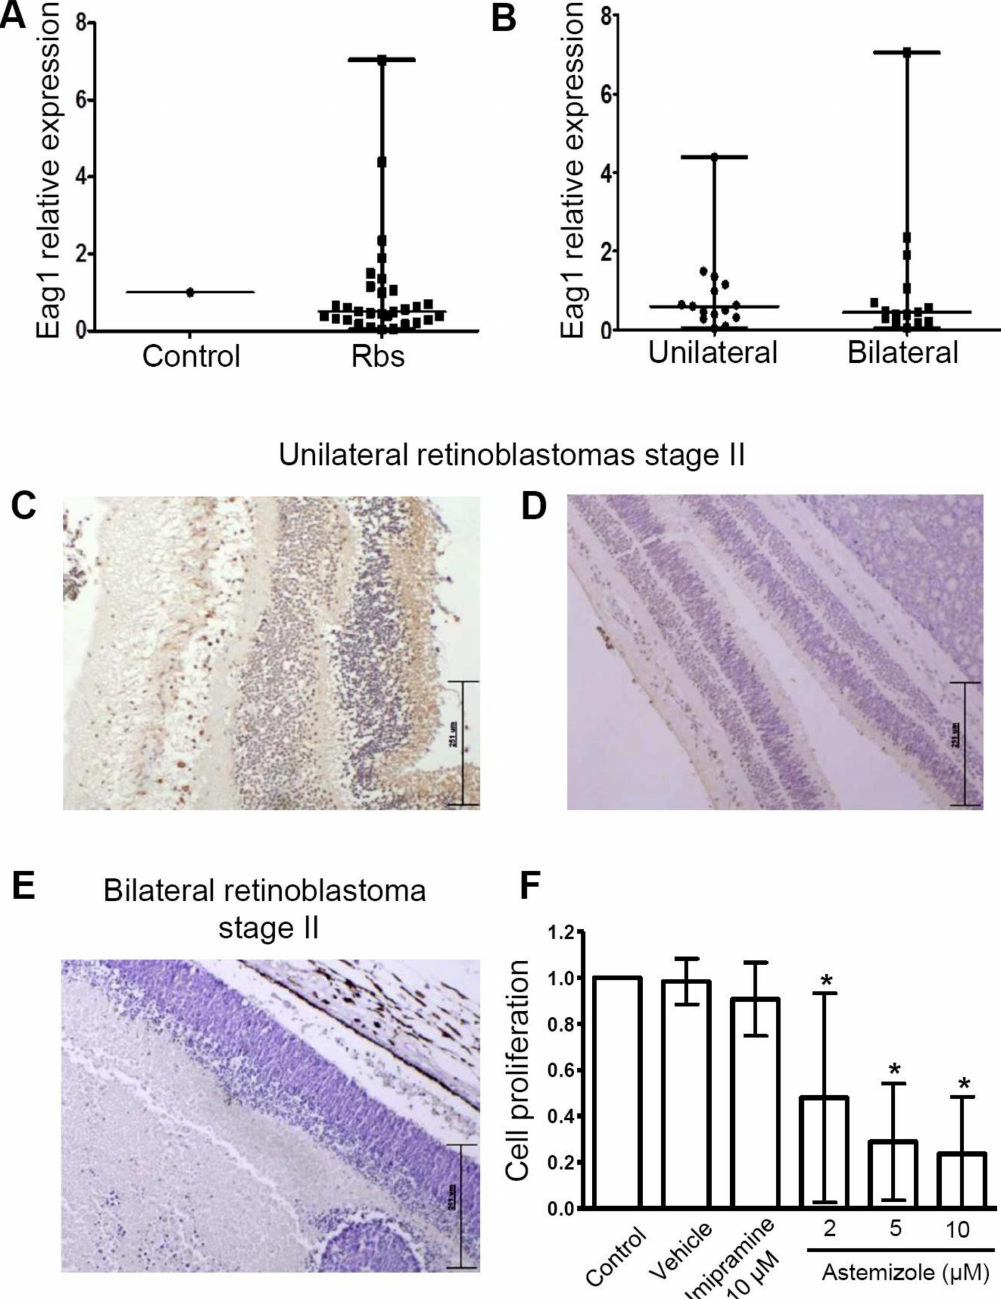
Figure 2. Eag1 was di ff erentially expressed in human retinoblastoma and astemizole inhibited cell proliferation. ( A ) In comparison with the control (pediatric normal brain obtained postmortem, where the Eag1 mRNA level was set to the value of 1, Eag1 mRNA expression was very heterogeneous between the retinoblastoma samples. Many samples showed a lower expression, while other samples had clearly higher Eag1 mRNA levels. No di ff erences in Eag1 expression versus the control was observed when separating the samples into unilateral ( n = 15) and bilateral ( n = 15) tumors ( B ). Examples of heterogeneous Eag1 protein expression studied using immunohistochemistry in three cases. Positive Eag1 expression in a zone of normal retina from an enucleated retinoblastoma case ( C ); weak Eag1 expression in retina and in tumor, upper right zone ( D ) and negative Eag1 expression ( E ). Magnification: 100 × . Astemizole decreased the cell proliferation (assayed by metabolic activity) in retinoblastoma primary cultures ( F ) ( n = 10). Each cell proliferation experiment was performed with sextuplicates. Panel (F) shows mean ± s.d. * p < 0.05 versus